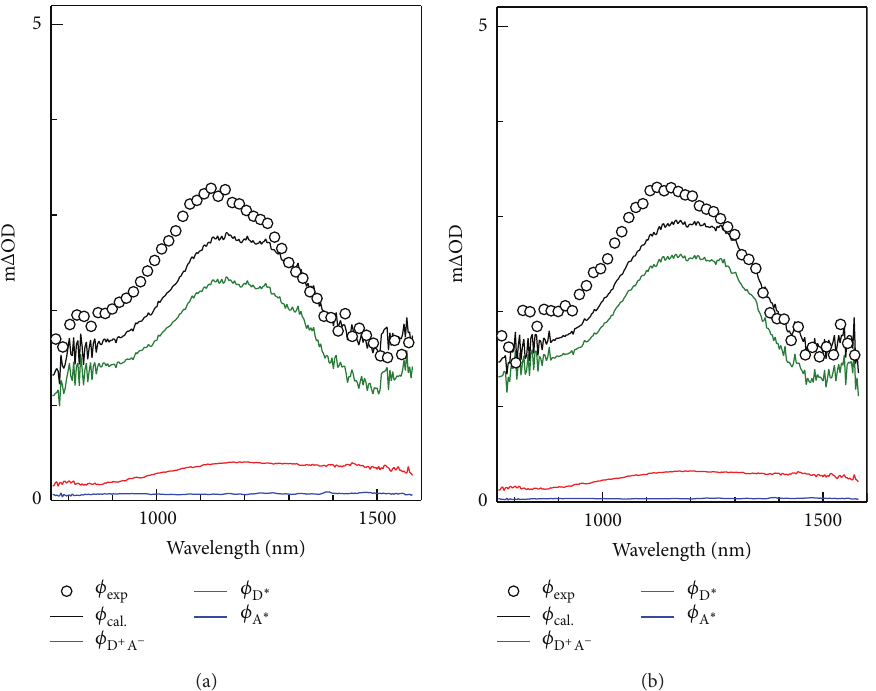
Figure 16: Δ OD spectra of SMDPPEH/PC 71 BM blend film at 0.9 ps at (a) 300 K and (b) 80K. Solid curves are results of the decomposition into 𝜙 D + A − , 𝜙 A ∗ , and 𝜙 D ∗